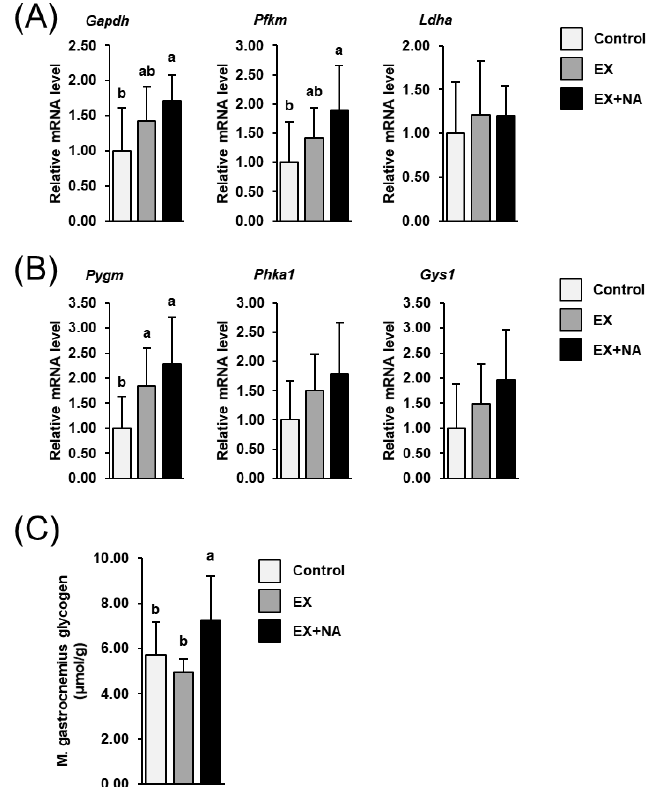
Figure 6. Relative mRNA levels of glycolytic genes ( A ), glyceraldehyde-3-phosphate dehydrogenase ( Gapdh ); phosphofructokinase, muscle ( Pfkm ); lactate dehydrogenase A ( Ldha )) and genes involved in glycogenolysis and glycogen synthesis ( B ), glycogen phosphorylase, muscle associated ( Pygm ); phosphorylase kinase regulatory subunit alpha 1 ( Phka1 ); glycogen synthase 1 ( Gys1 )) and